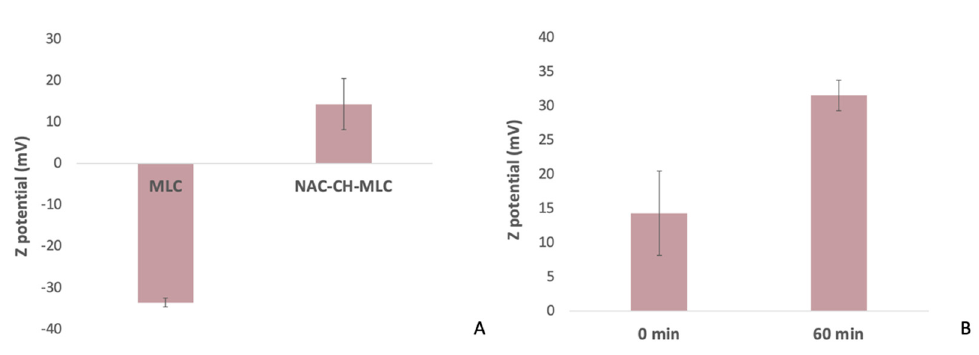
Figure 2. ( A ) MLC and NAC-CH-MLC Z potential; ( B ) NAC-CH-MLC Z potential at 0 min and 60 min of soaking.